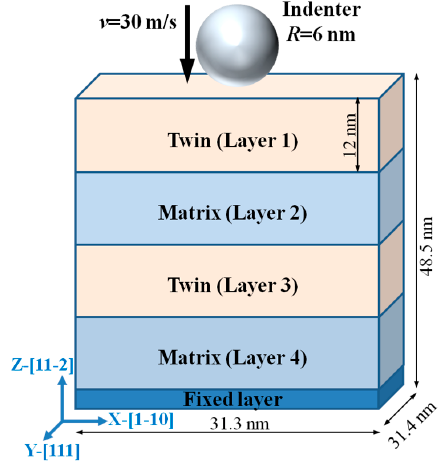
Figure 1. Setup of nanoindentation.